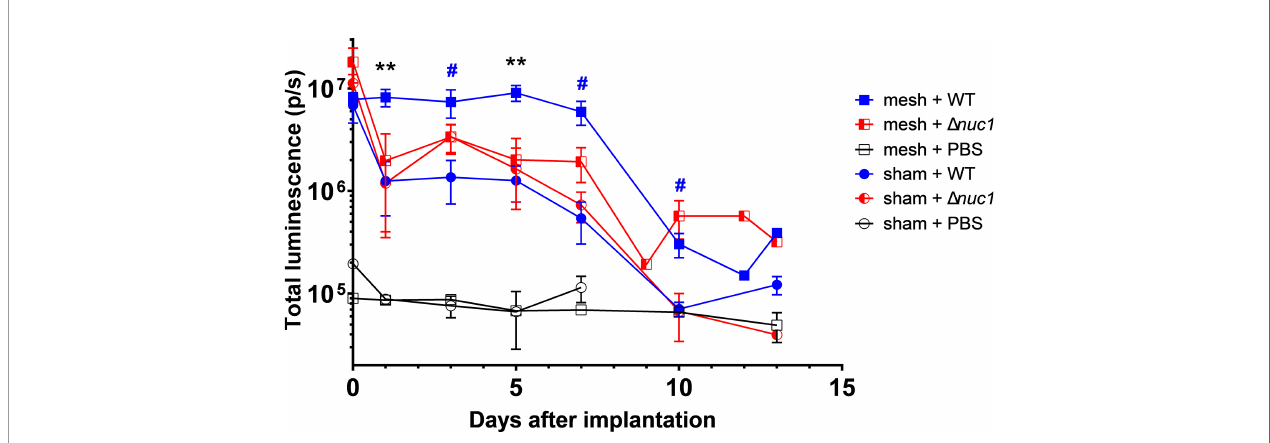
FIGURE 1 | Bacterial bioluminescence measured during the course of infection in PVDF surgical mesh implanted mice inoculated with either S. aureus Newman WT lux (WT), S. aureus Newman D nuc1 lux ( D nuc1 ), or sterile PBS. Sham indicates mice that underwent surgery without implantation of a mesh. Error bars represent standard error of the mean. Differences were analyzed using a repeated measures ANOVA, corrected for multiple measuring and lognormal values. Lognormality was con fi rmed using a Q-Q plot. Black asterisks indicate signi fi cant differences between mesh + WT and mesh + D nuc1, blue hashtags indicate signi fi cant difference between mesh + WT and sham + WT. # P ≤ 0.05; **P ≤ 0.01. Numbers of mice included in the statistical